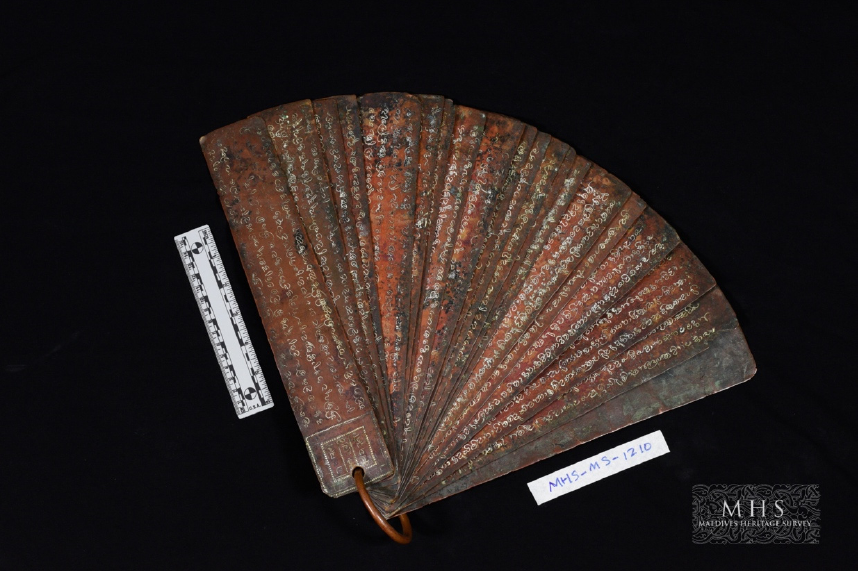
Figure 5. A 12-century copper-plate inscription digitized by the Maldives Heritage Survey. The full text of this and hundreds of other manuscripts are open-access available on the project website: https://maritimeasiaheritage.cseas.kyoto-u.ac.jp/manuscript-viewer/waqf-endowment/ (accessed 25 April 2022).